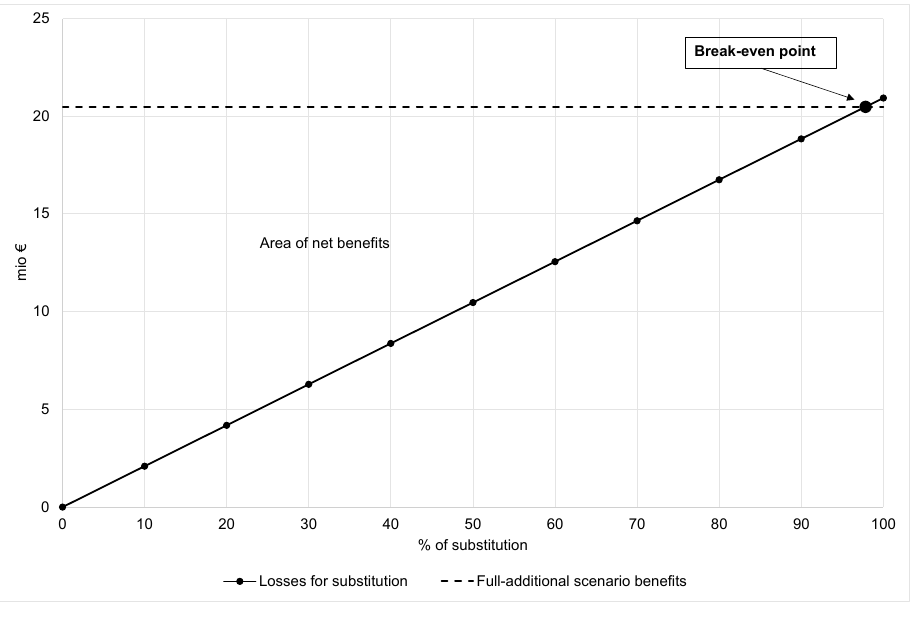
Figure 3. Benefits and losses in terms of value added generated by the cardoon supply chain in Sar- dinia,